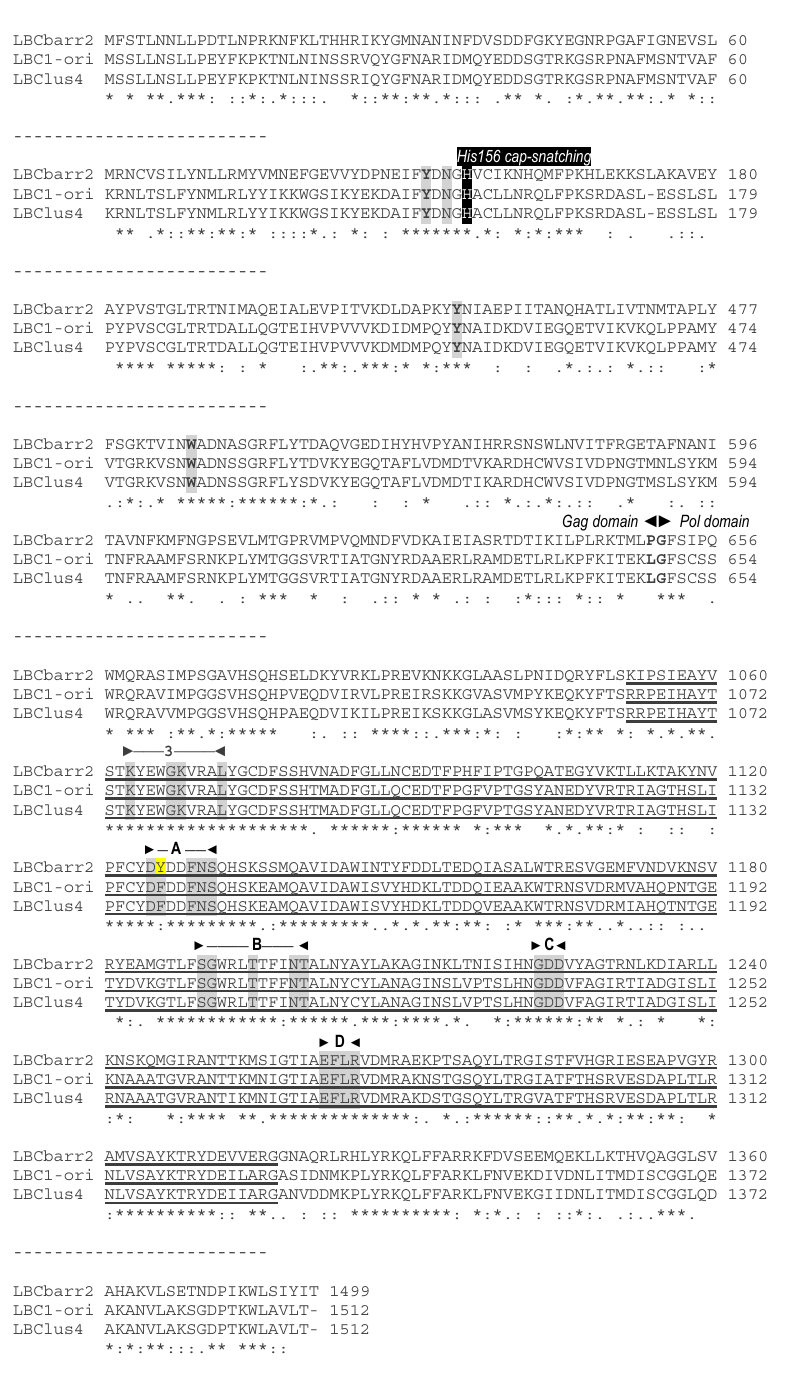
Figure 3. Comparison between partial amino-acid sequences of Gag-Pol encoded by ScV-LBC1-original, ScV-LBClus4, and TdV-LBCbarr2 genomes. The full sequence alignment is presented in Supplemental Material (Figure S2). The separation between Gag and Pol is indicated (Gag ◄► Pol). The H156 residue required for 5’cap-snatching is black shaded. The four crucial residues for cap recognition (Tyr-152, Asn-154, Tyr-452 and Trp-545) are grey shaded. The highly conserved central third of Pol (RdRp domain) is underlined, the five consensus motifs (3, A, B, C, and D) conserved in RNA-dependent RNA polymerases from Totiviruses are indicated above the sequence, and the conserved amino acids for each motif are grey shaded. Different residue in TdV-LBCbarr with respect to ScV-LBC is yellow shaded. Asterisks (*) indicate identical amino acids; colons (:) and single dots (.) indicate conserved and semi-conserved amino acids, respectively.